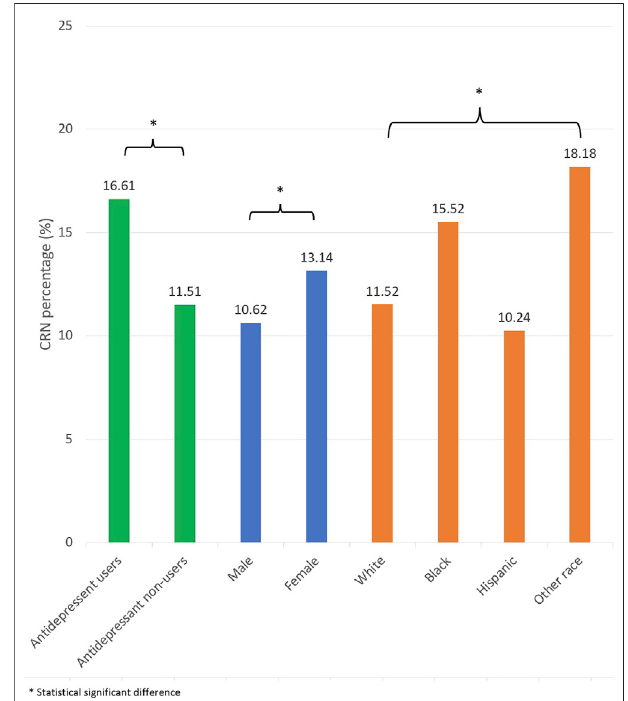
FIGURE 1 | CRN prevalence by antidepressant use for racial/ethnicity and